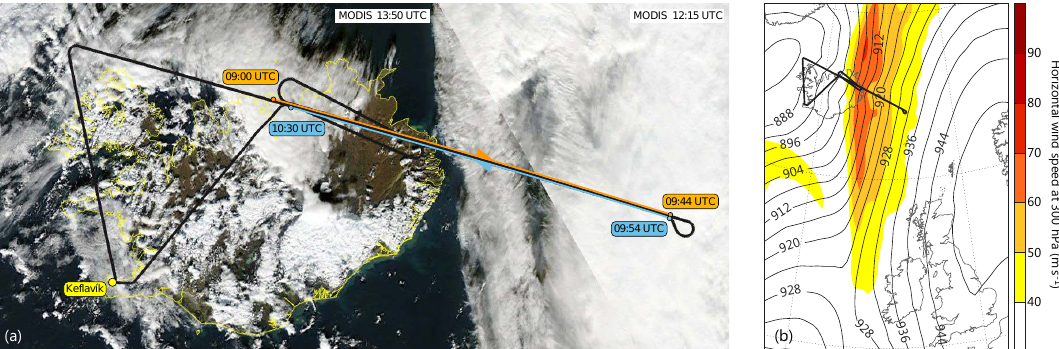
Figure 10. (a) Flight track of the Falcon aircraft (black line) during the research flight conducted on 4 October 2016. The wind scenes performed from 09:00 to 09:44 and from 09:54 to 10:30UTC are indicated in orange and blue. High ground visibility was obtained over the northeast of Iceland at the beginning and the end of the scenes, respectively. The background picture is composed of a map provided by Google Earth and satellite images from Aqua MODIS (VIS channel) taken at 12:15 (right part) and 13:50UTC (left part) (MODIS, 2017b). (b) Geopotential height (black isolines, in dekametres) and horizontal wind speed (colour shading) at 300hPa over the North Atlantic on 4 October 2016, 12:00UTC, from ECMWF model analysis together with the flight track of the Falcon 20 aircraft. Table 5. Results of the statistical comparison between the A2D and the 2µm LOS wind data measured on 4 October 2016. The statistical comparison for the Mie wind profiles was performed without and with ZWC. Statistical